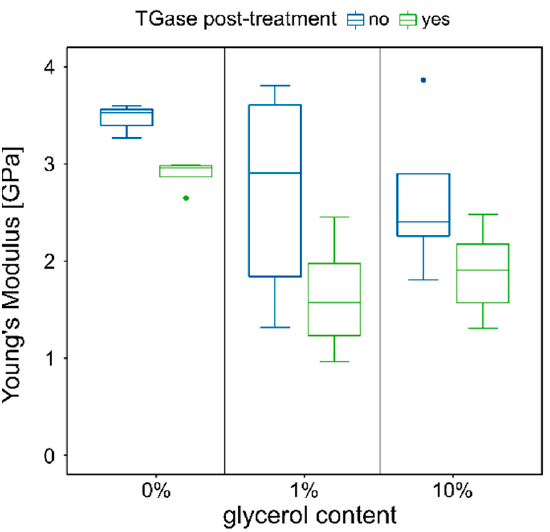
Figure 4. Mechanical properties of p -CMs fibers post-treated with TGase and spun without or with 1% and 10% glycerol.